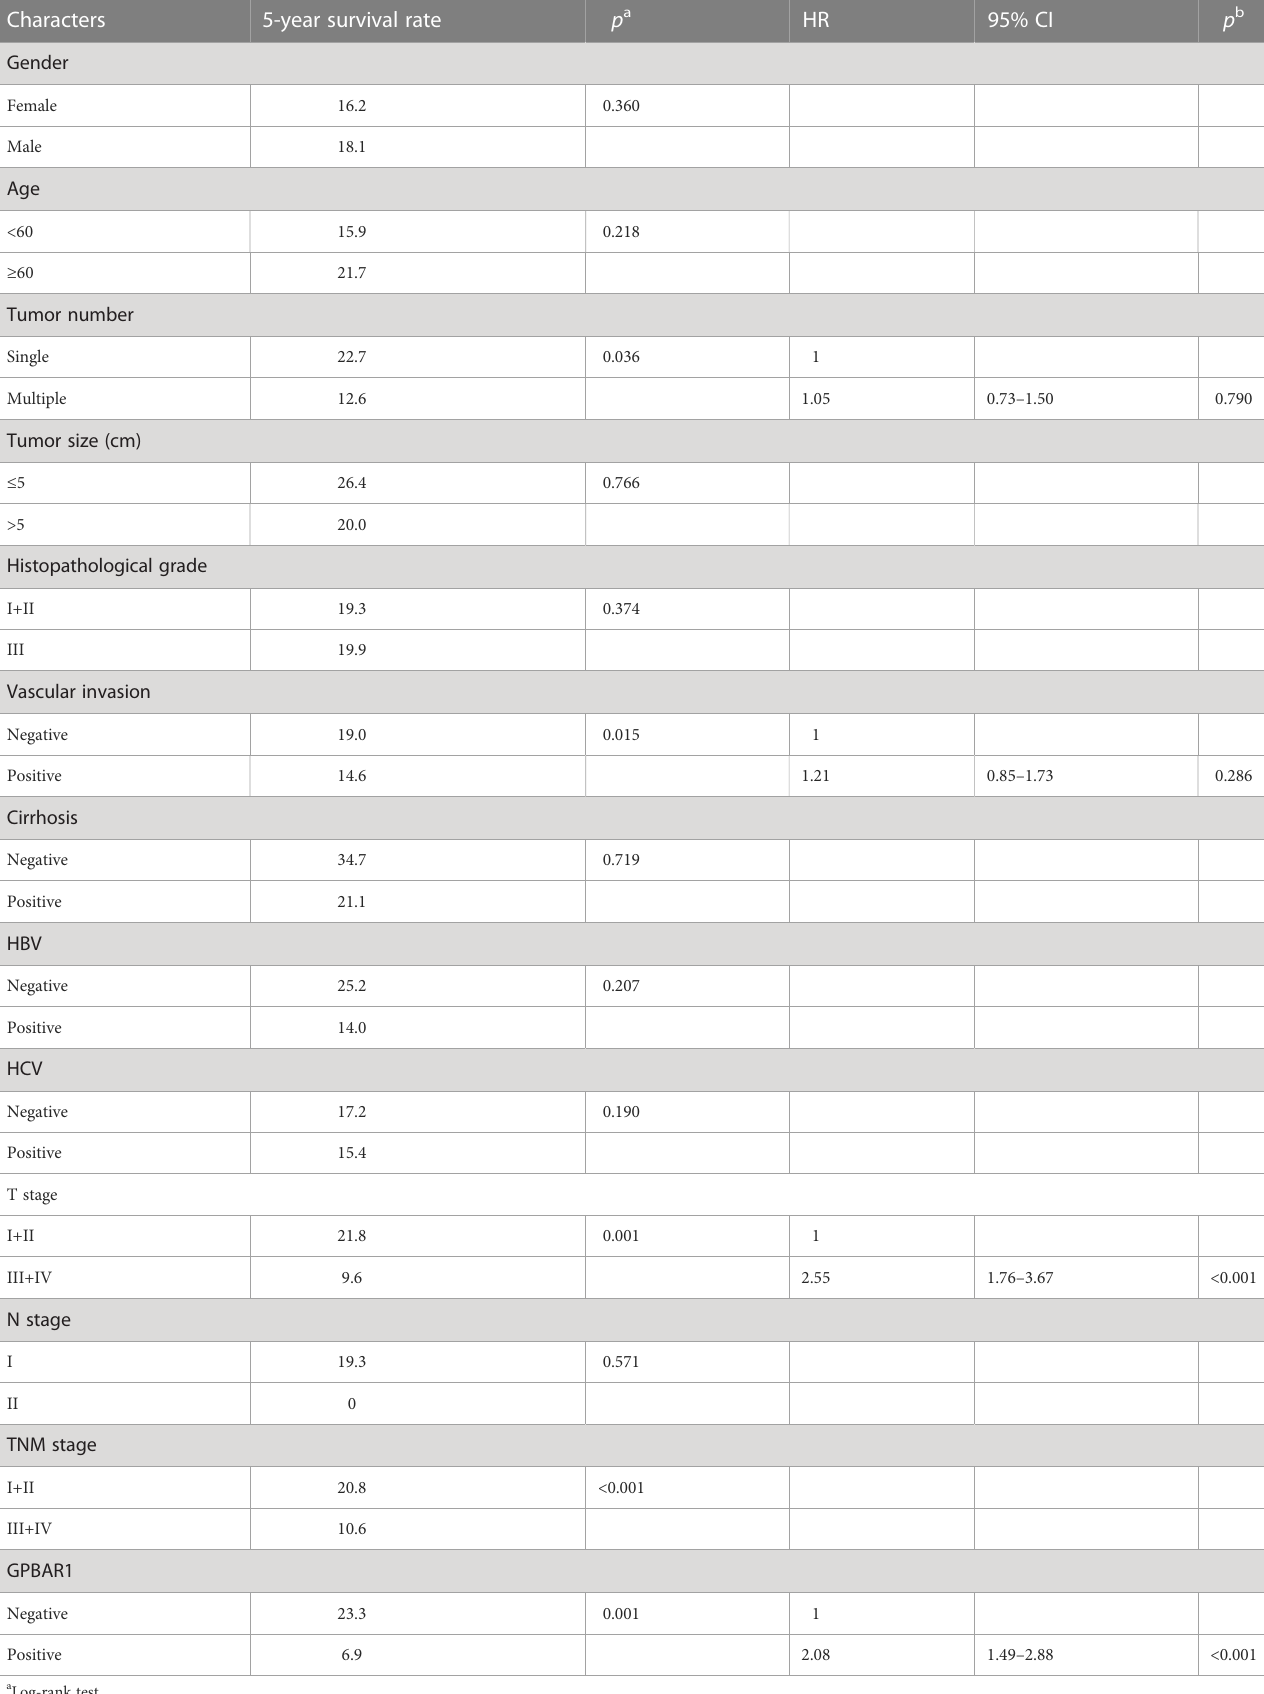
TABLE 2 The prognostic signi fi cance of GPBAR1 and other clinicopathological factors.